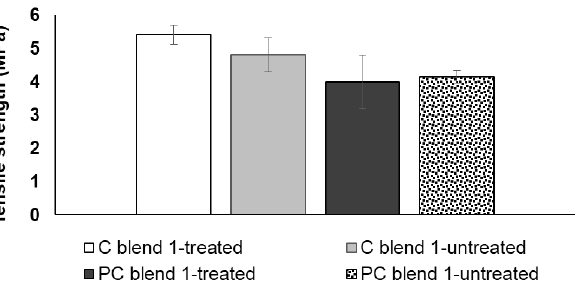
Figure 9. Tensile strength of treated and untreated cotton and polycotton blends.